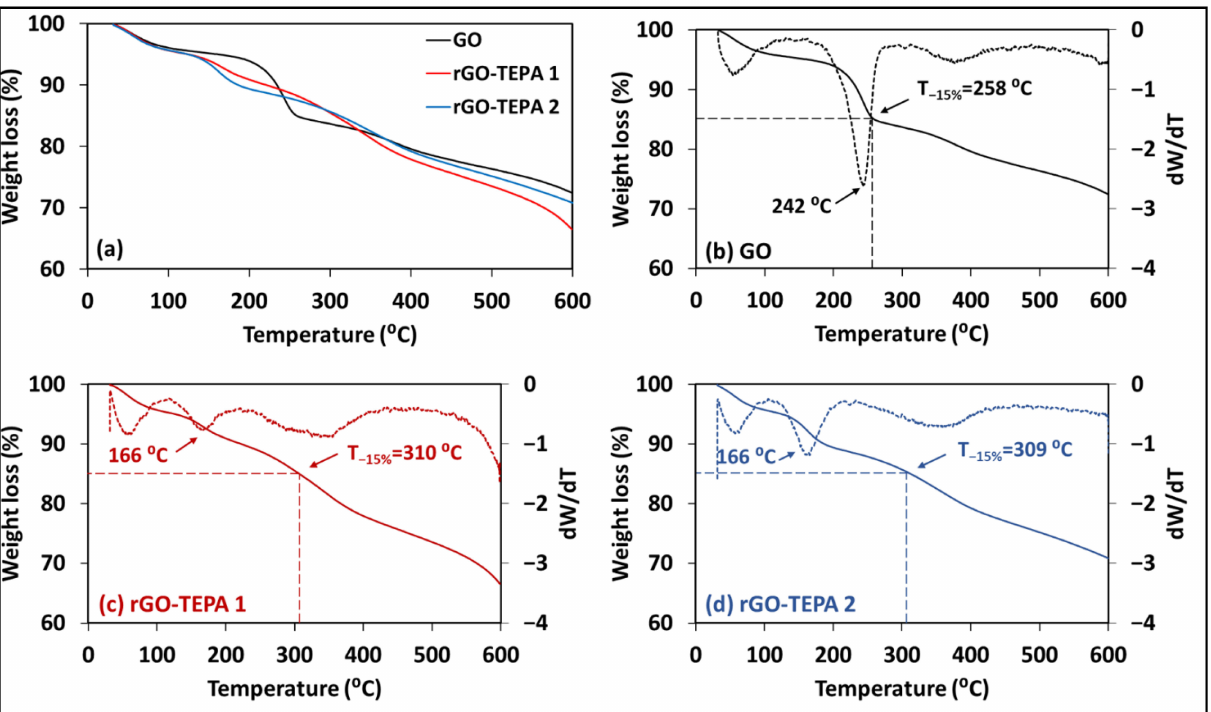
Figure 12. ( a ) TGA curves of the prepared samples: TGA (solid lines) and D-TGA (dotted lines) curves of ( b ) the pristine GO, ( c ) rGO-TEPA1, and ( d )